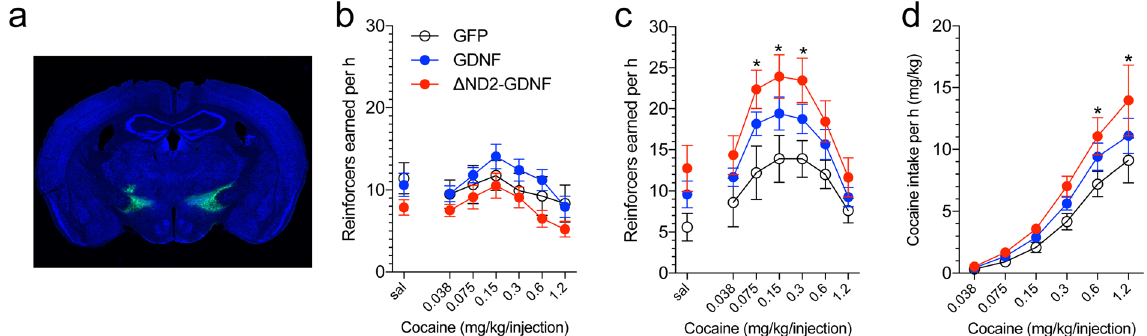
Figure 2. Effect of lateral hypothalamus delivery of GDNF-AAV and Δ N2-GDNF-AAV on cocaine self- administration in wildtype and syndecan-3 knockout mice. A unit dose-response paradigm was used to probe the effects of GDNF heparin binding in syndecan-3 knockout and wildtype mice under an FR5 schedule of reinforcement 8 . ( a ) GDNF-AAV or Δ N2-GDNF-AAV was injected in the LH in wildtype and syndecan-3 KO mice. ( b ) No significant effect of GDNF-AAV or Δ N2-GDNF viruses was observed in wildtype (WT) mice compared with the GFP control group ( F 2,228 = 1.48, P > 0.05, two-way repeated-measures ANOVA). GFP, n = 12; GDNF, n = 15; Δ ND2-GDNF, n = 14. ( c ) In syndecan-3 knockout mice, both the GDNF-AAV and Δ N2-GDNF-AAV viruses caused an upward shift of the cocaine unit dose-response curve compared with the GFP control group. The two-way repeated-measures ANOVA revealed a significant main effect of virus infusion ( F 2,180 = 4.26, P = 0.024). GFP, n = 10; GDNF, n = 12; Δ ND2-GDNF, n = 11. The post hoc test revealed a significant group difference between the Δ N2-GDNF-AAV group and GFP group at the doses of 0.075, 0.15, and 0.3 mg/kg/injection. ( d ) Δ N2-GDNF-AAV delivery increased cocaine intake compared with the GFP control group. The two-way repeated-measures ANOVA revealed a significant main effect of viral infusion ( F 2,30 = 2.828, P = 0.075). GFP, n = 10; GDNF, n = 12; Δ ND2-GDNF, n = 11. The post hoc test revealed a significant group difference between the Δ N2-GDNF-AAV group and GFP group at the doses of 0.6 and 1.2 mg/kg/injection. The data are expressed as mean ±